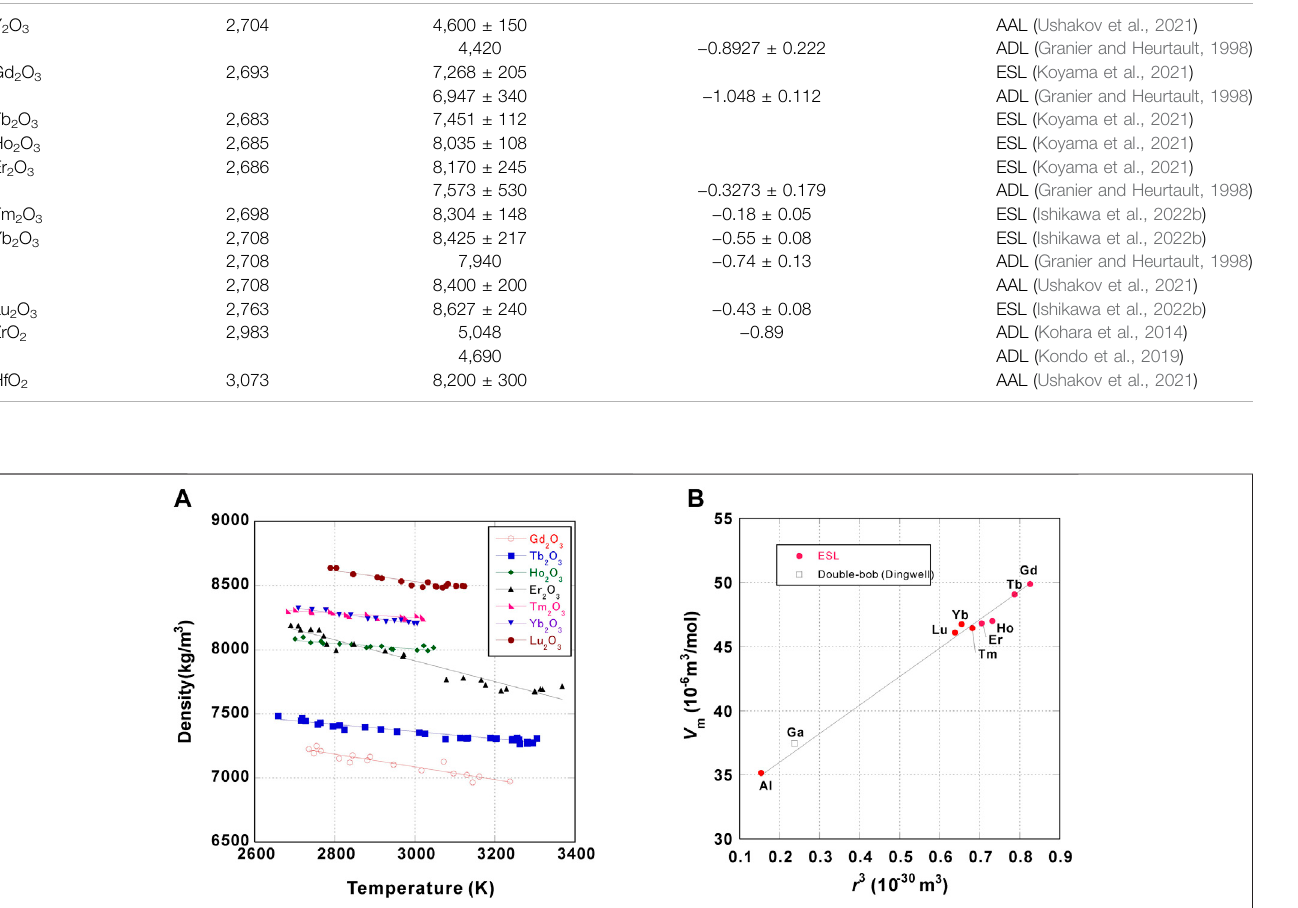
TABLE 4 | Density of molten Ln 2 O 3 , ZrO 2 , and HfO 2 . Samples